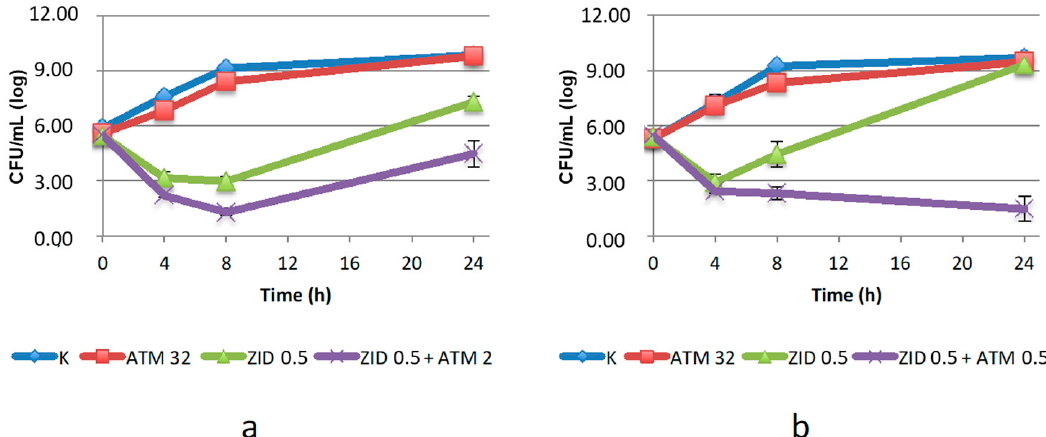
Figure 3. Twenty-four-hour time–kill curves of aztreonam (ATM) and zidebactam (ZID), alone and in combination, on: ( a ) C. amalonaticus N18; ( b ) K. pneumoniae KL 12 SG. K: positive control (without the addition of antimicrobials). Mean values and standard deviation of three independent experiments are reported.